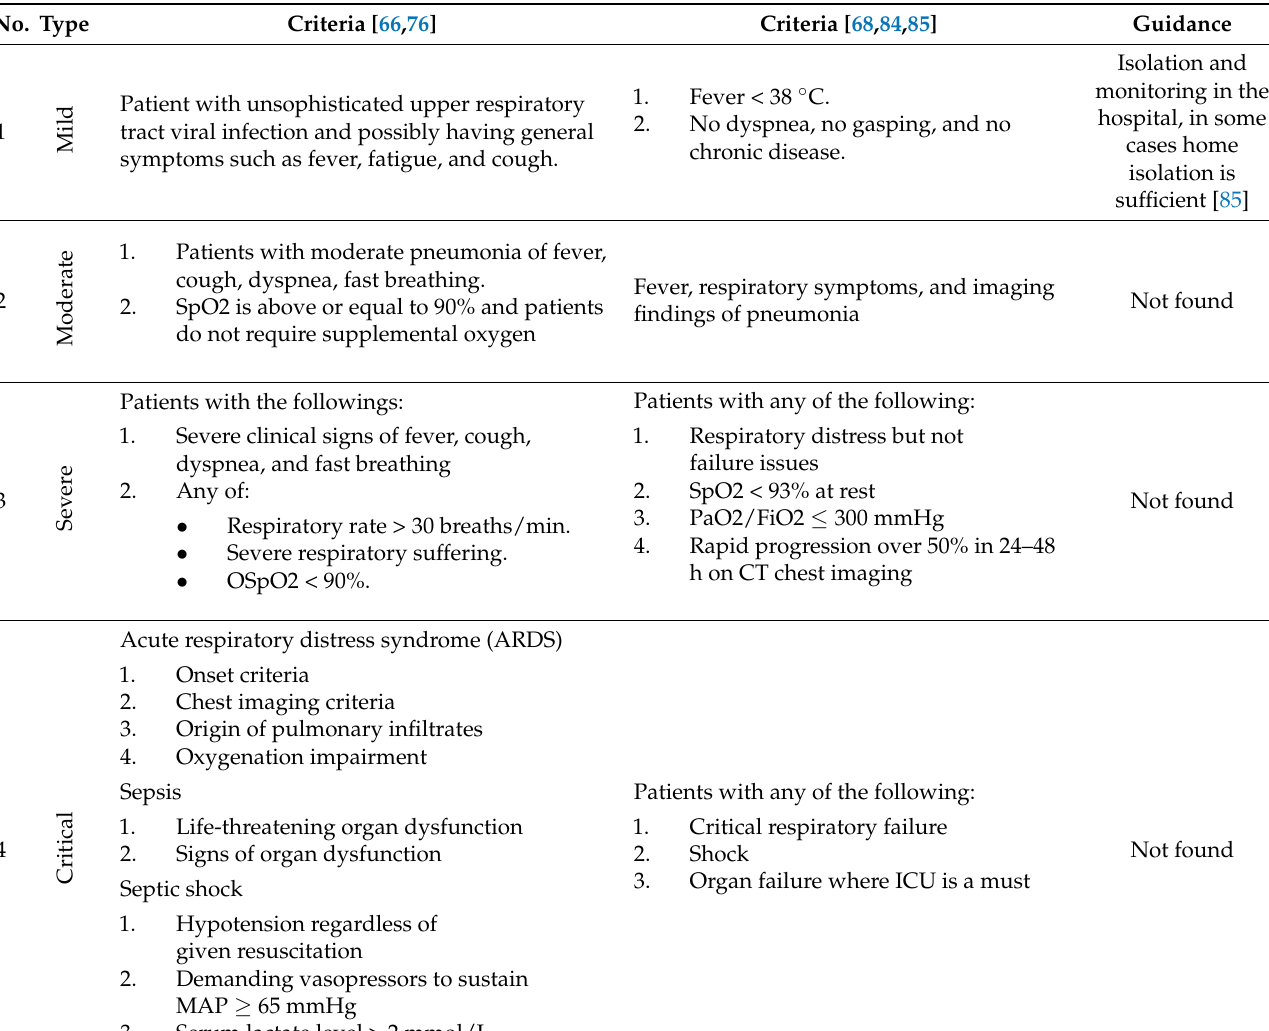
Table 4. Classification criteria of COVID-19 patients in approach